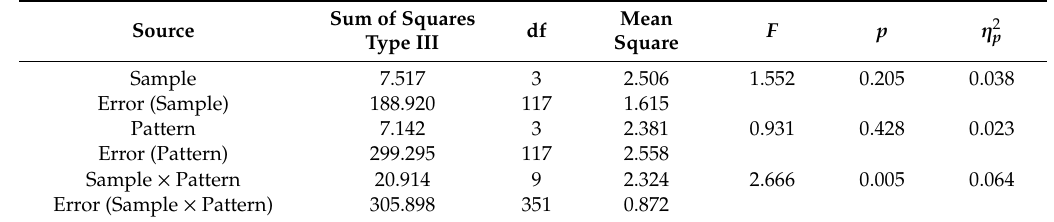
Table 5. Results of four-way mixed ANOVA for grip comfort (Test result of within subject e ff